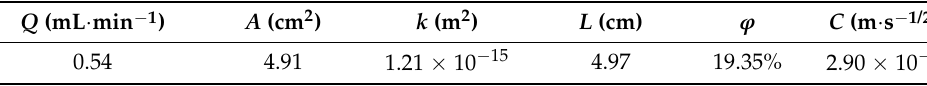
Figure 12. Filtration curves of surfactant gel. Table 1. Calculation results of filtration coefficient.